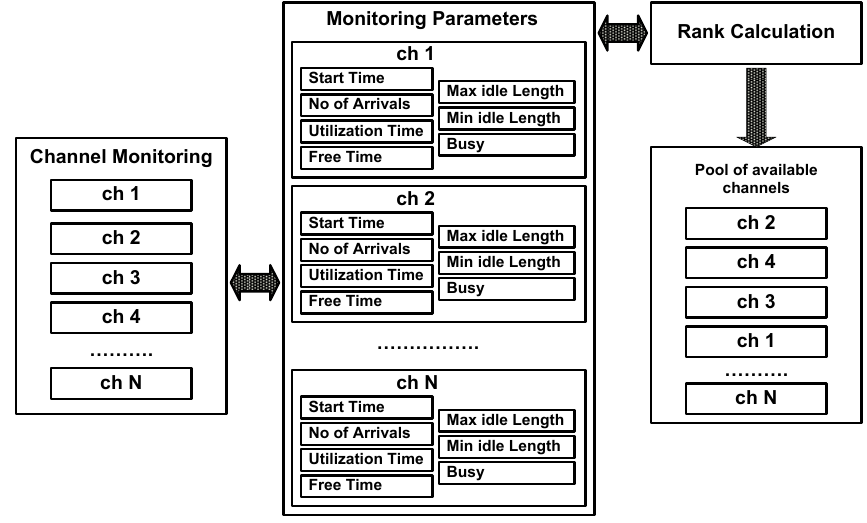
Figure 5. PU activity monitoring and channel indexing